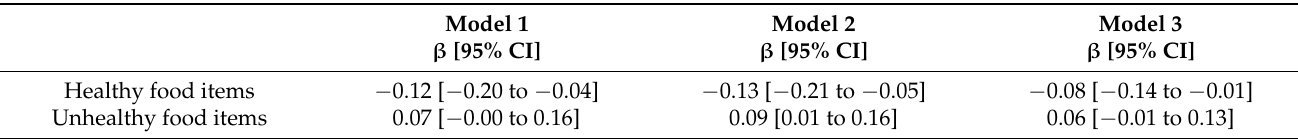
Table 4. Regression models for the relationship between the Bergen Burnout Index score and consumption of healthy and unhealthy food